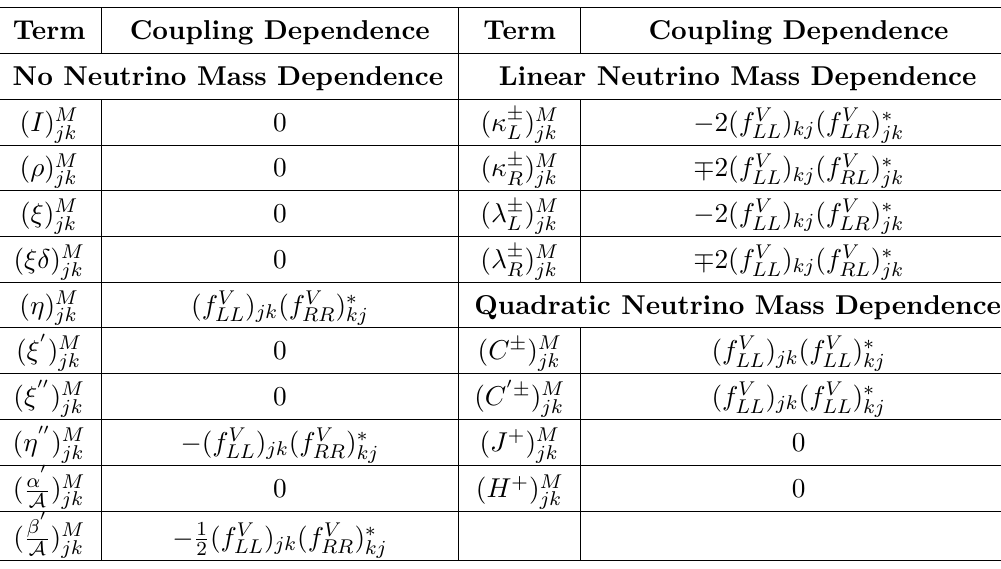
Table 8. Majorana term for V ± A